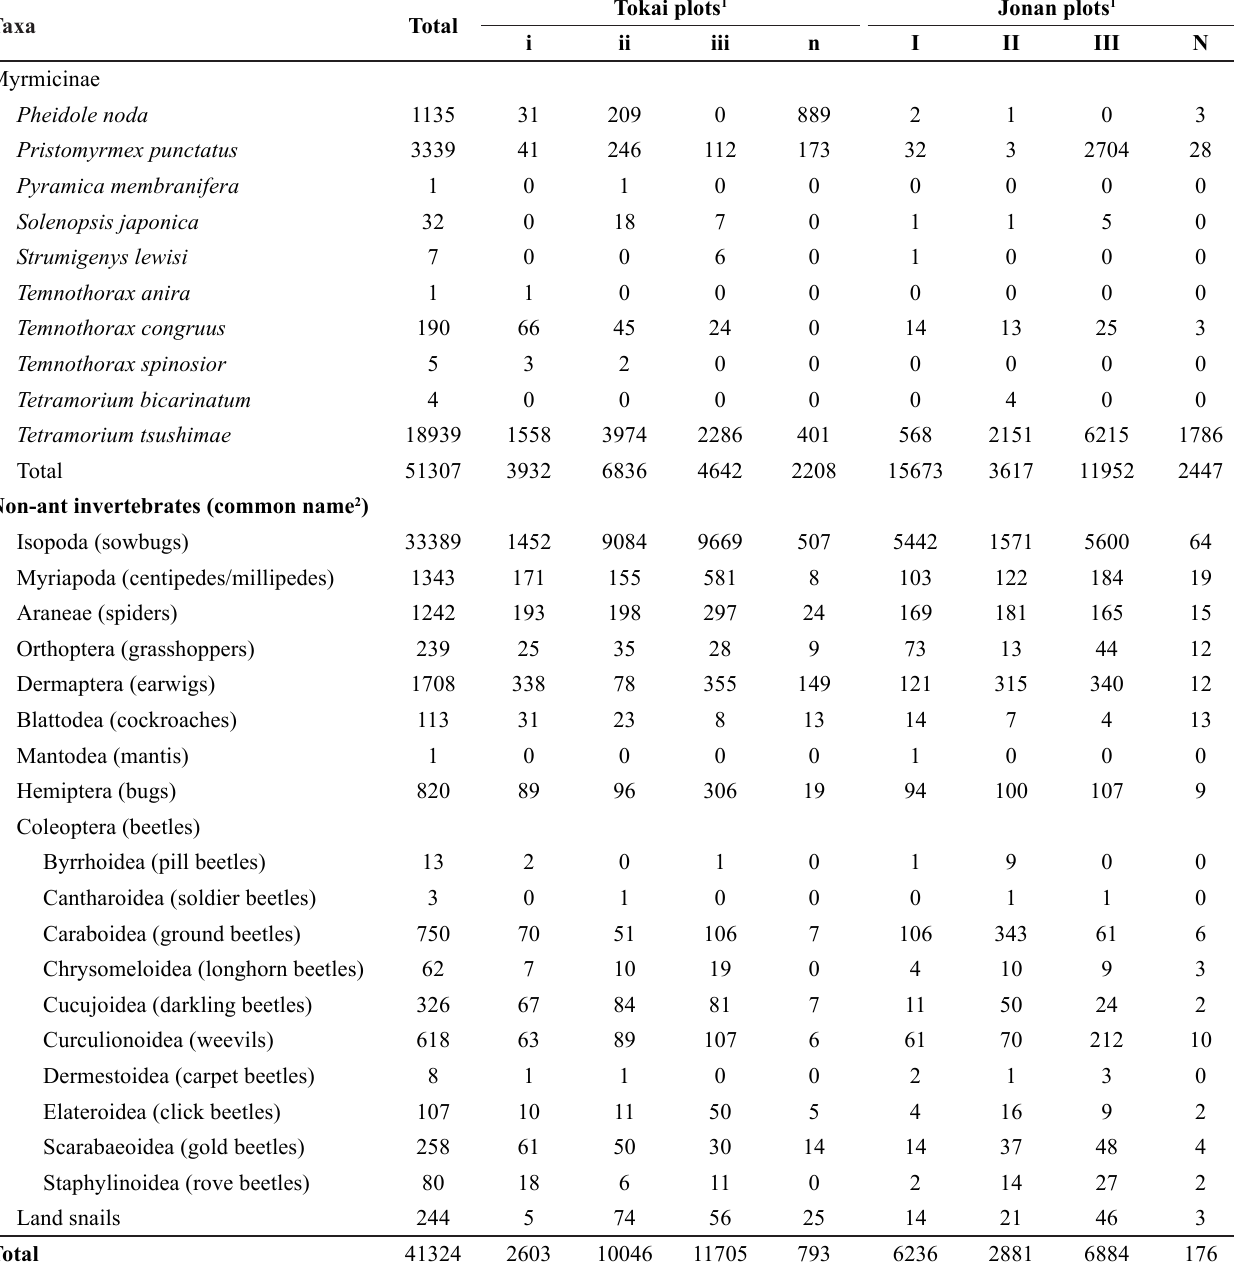
Table 1. Total numbers of each ant species and non-ant invertebrate taxonomic groups collected in monitoring traps at the Tokai and Jonan sites. (Continuation)